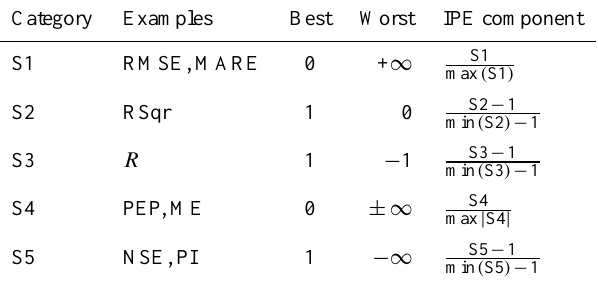
Table 1. Fivefold classification of potential components used in